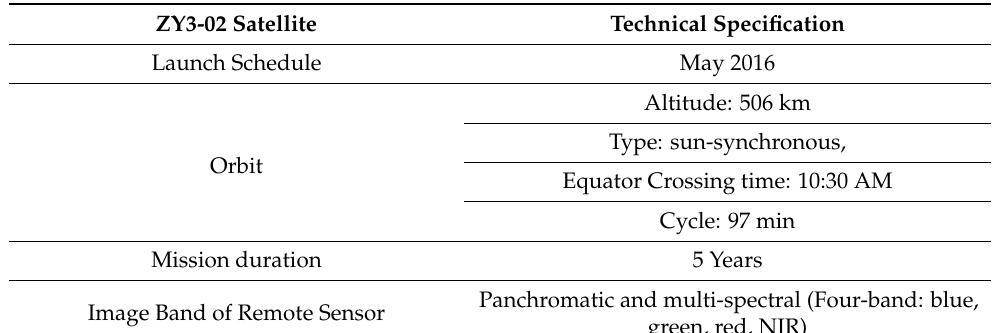
Table 1. The technical specification of ZY3-02